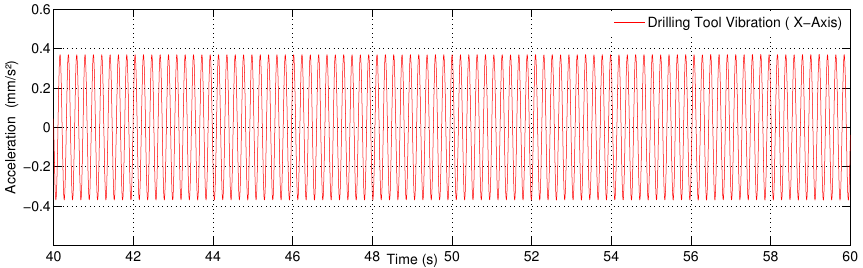
Figure 6. Drilling Tool vibration along the x-direction.